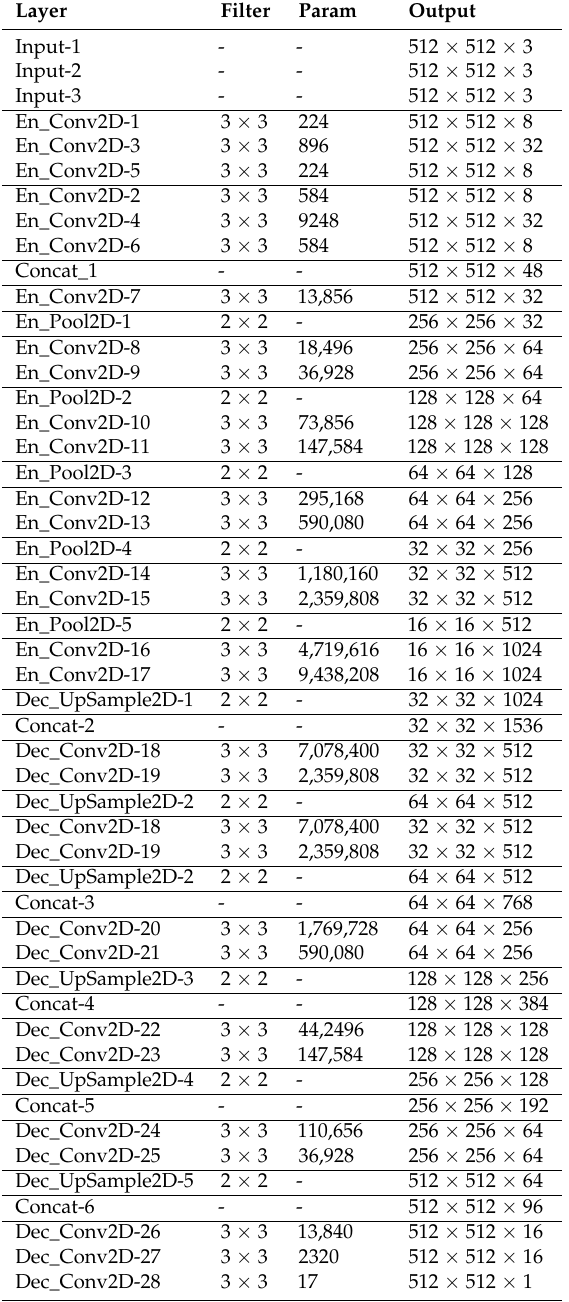
Table 1. A detailed configuration of PedNet. “En_Conv” and “Dec_Conv” corresponds to the convolution in the encoder and decoder network. Batch normalization and ReLu are omitted from the table for clarity but each convolution is followed by these two